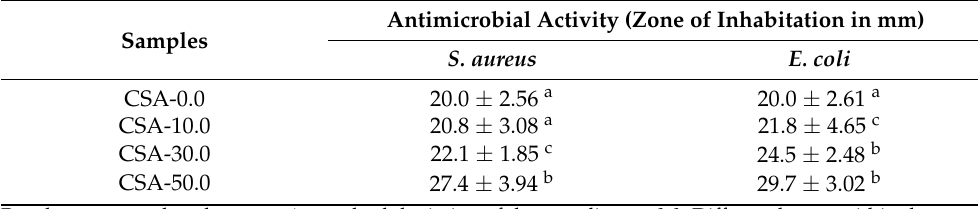
Table 3. Antimicrobial activity of chitosan and its composites against S. aureus and E. coli . Antimicrobial Activity (Zone of Inhabitation in mm) Samples S. aureus